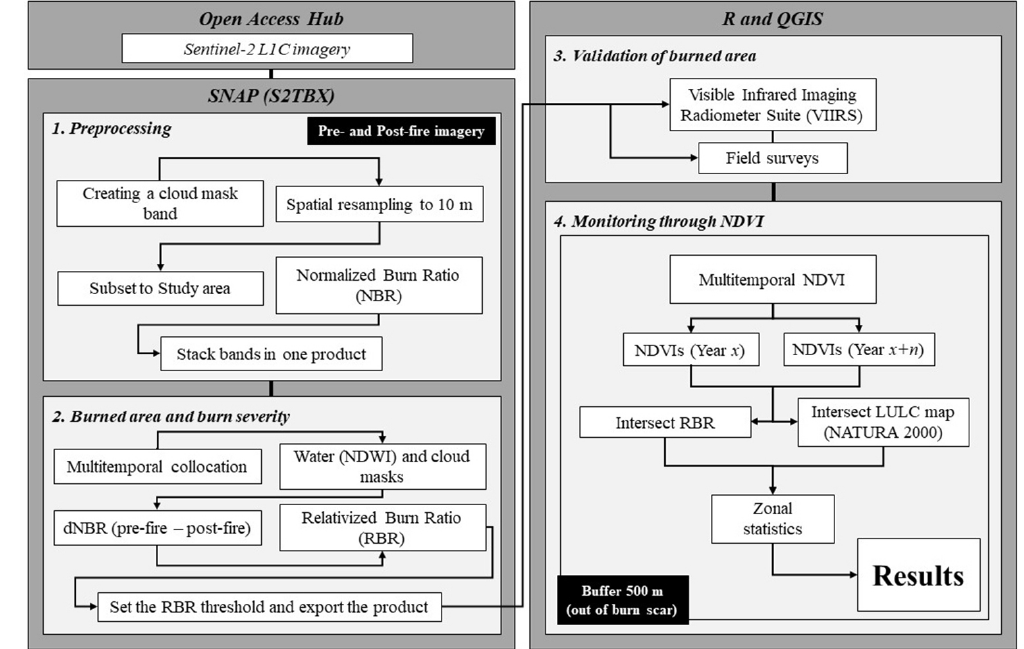
Figure 4. Simplified workflow. Scheme of the procedure for the identification and monitoring of the areas burned by S2